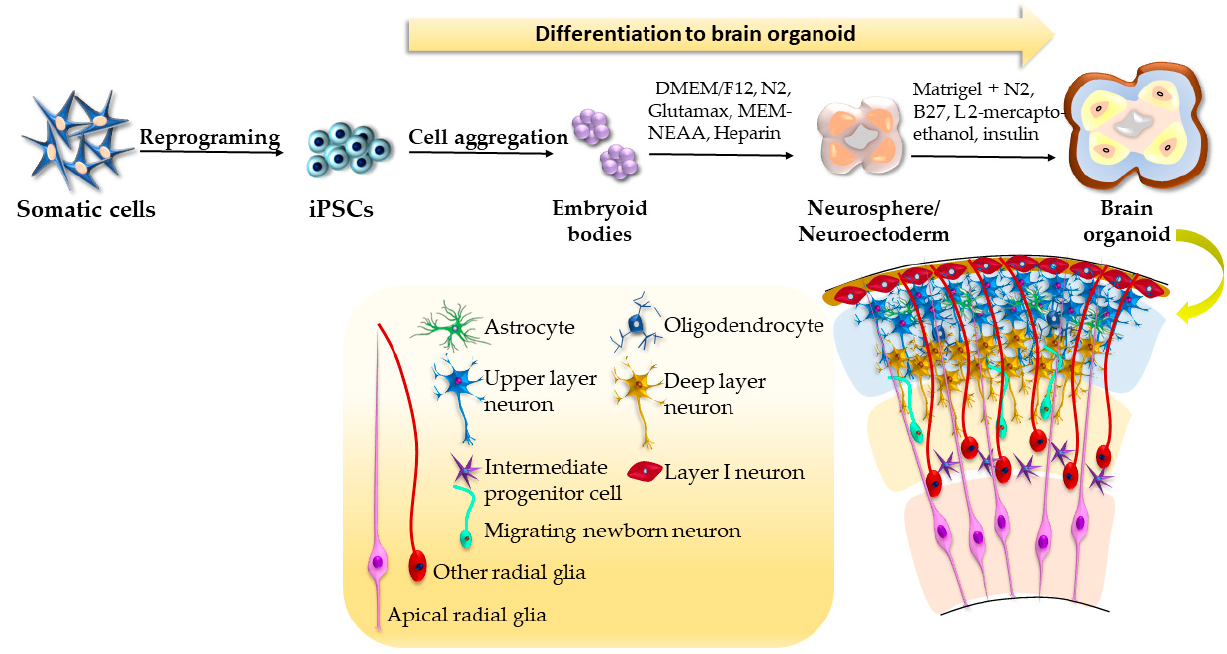
Figure 2. Generation of brain organoids according to the protocol by Lancaster et al. [64].